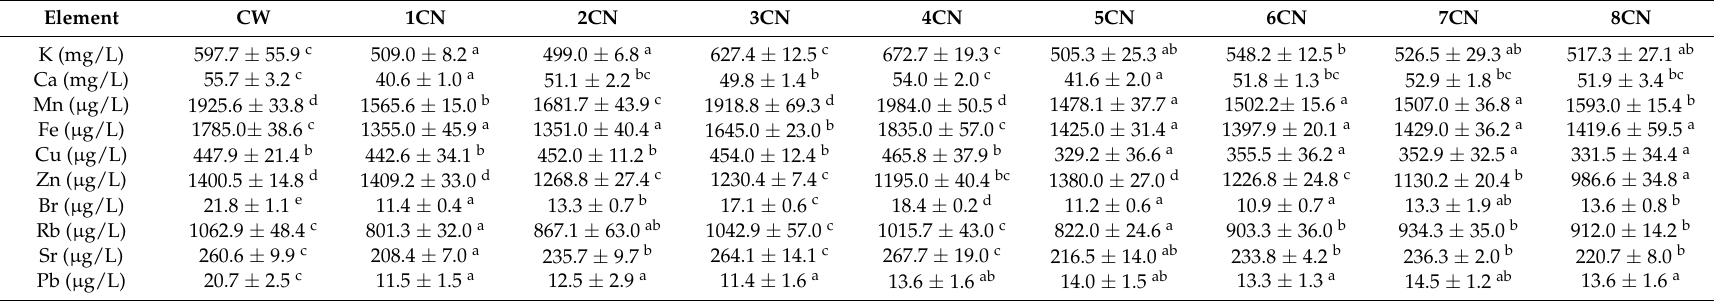
Table 9. Content of elements in the initial conventional Cabernet Sauvignon wine and NF retentates obtained at 2.5, 3.5, 4.5 and 5.5 MPa with cooling and without cooling. Significant differences ( p < 0.05) between samples are indicated by different superscript letters (a, b, c, d, e) within the row (ANOVA, Fisher’s LSD test). Element